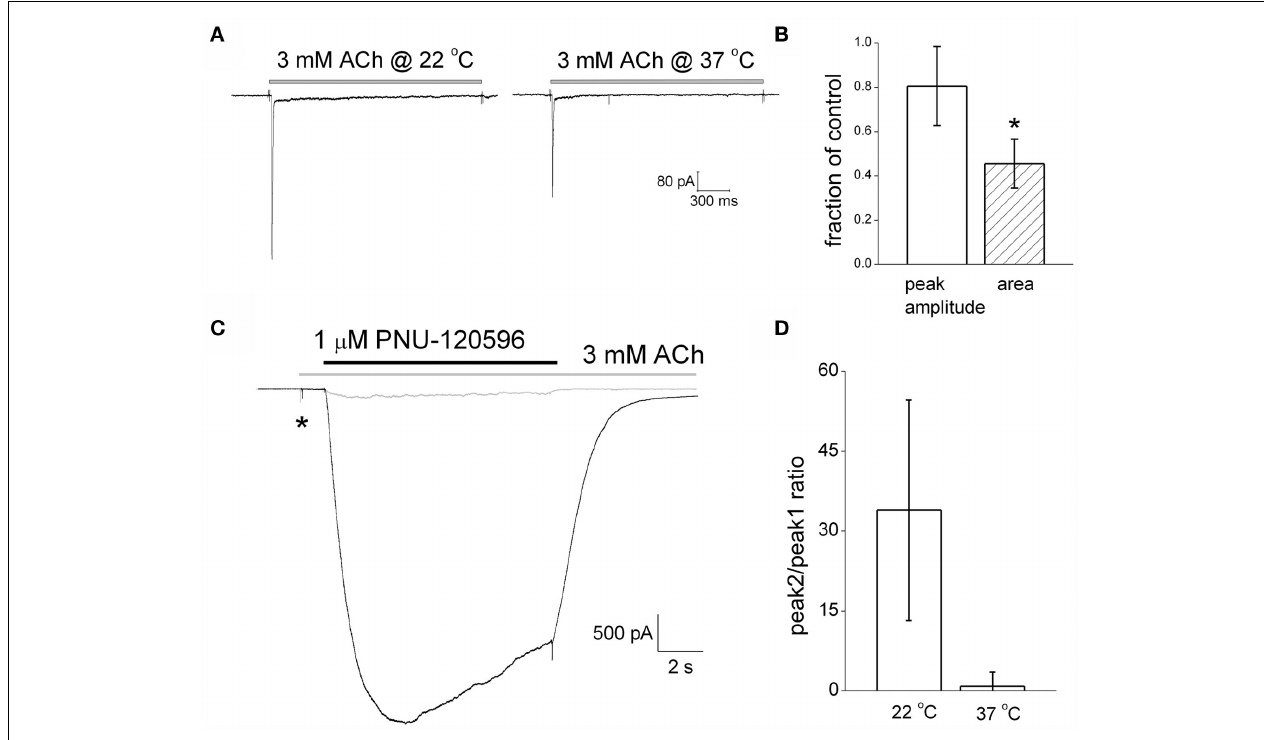
PNU120596-mediated reversal of ACh-evoked desensitization at room temperature (black trace) and 37˚C (gray trace). (D) A histogram showing the ratio between the dedesensitized peak current (P2) evoked by PNU120596 and the initial desensitizing ACh response (P1) at room temperature and 37˚C.